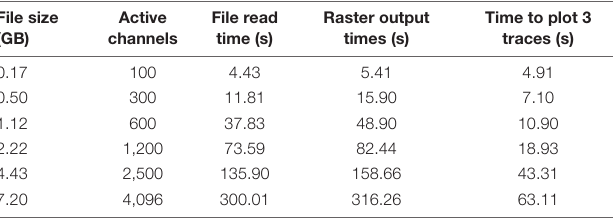
TABLE 1 | Benchmarking numbers for Xenon LFP analysis